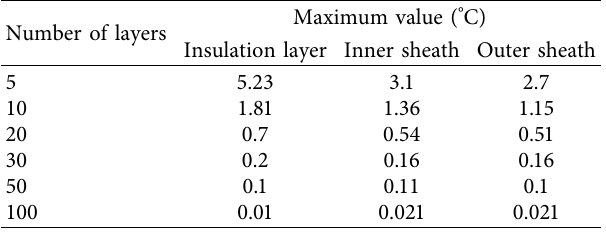
Table 4: The maximum value of the increased calculation accuracy value relative to the front level layering.